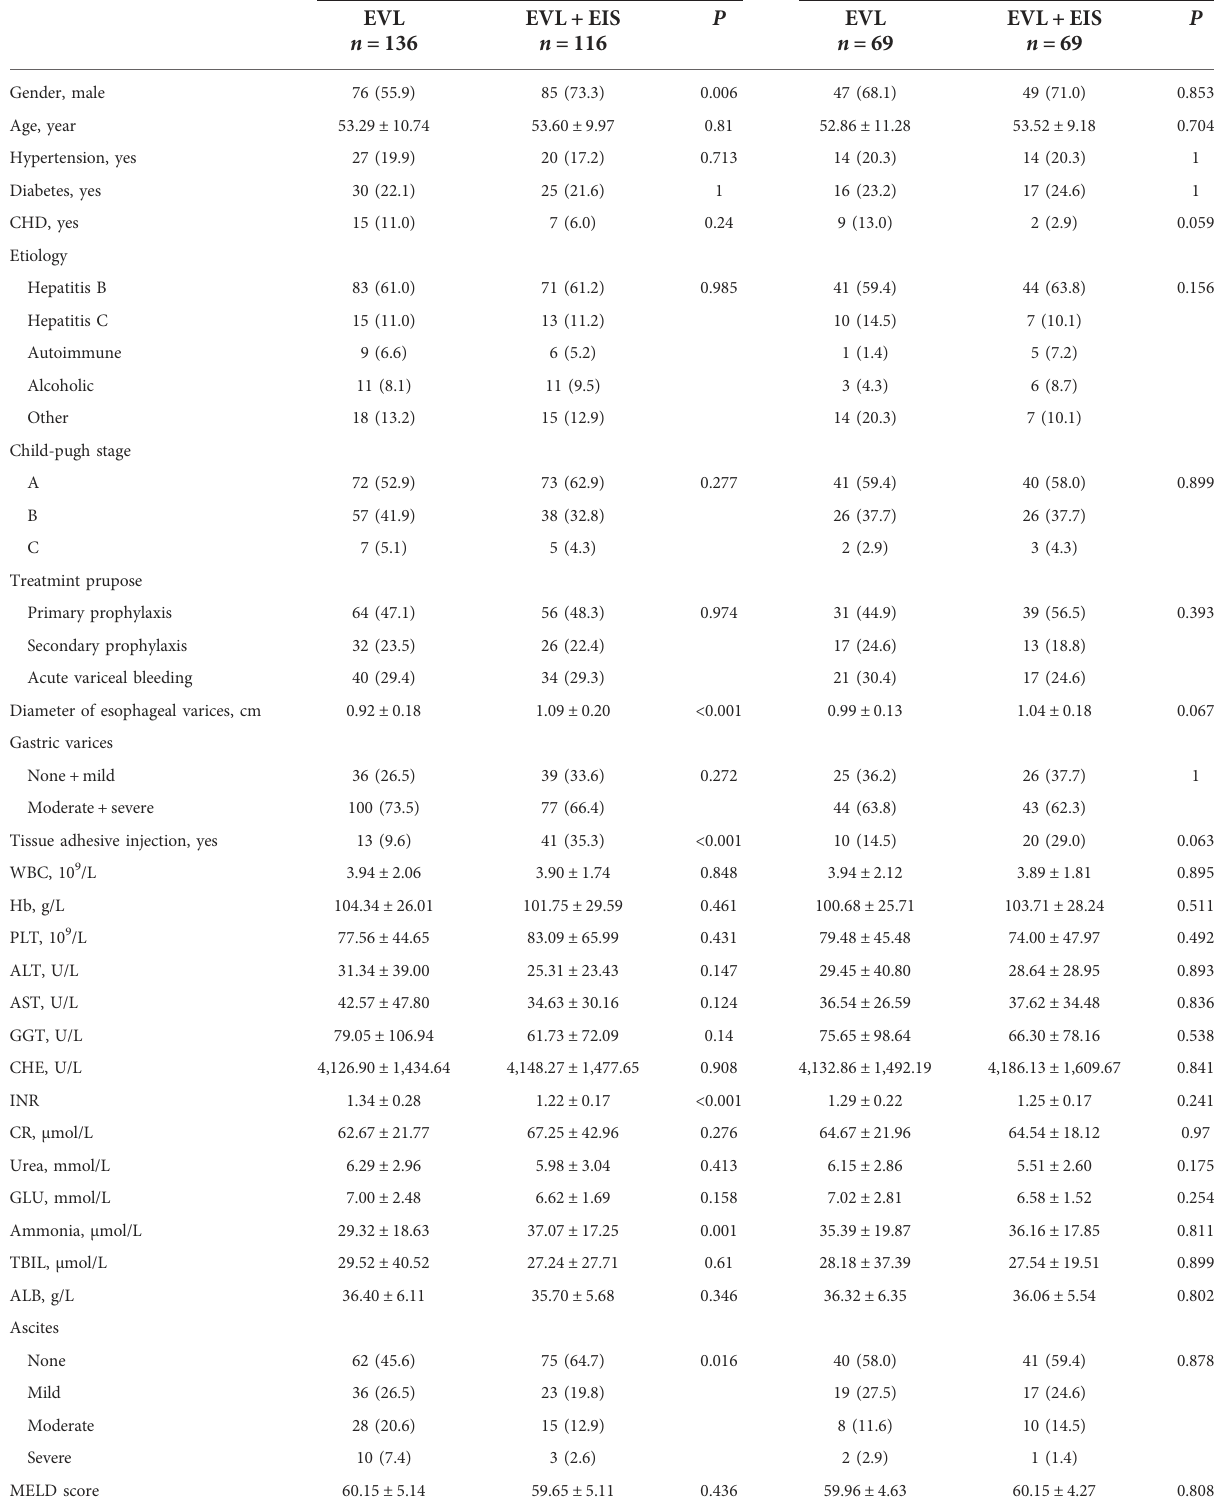
TABLE 1 Baseline patient